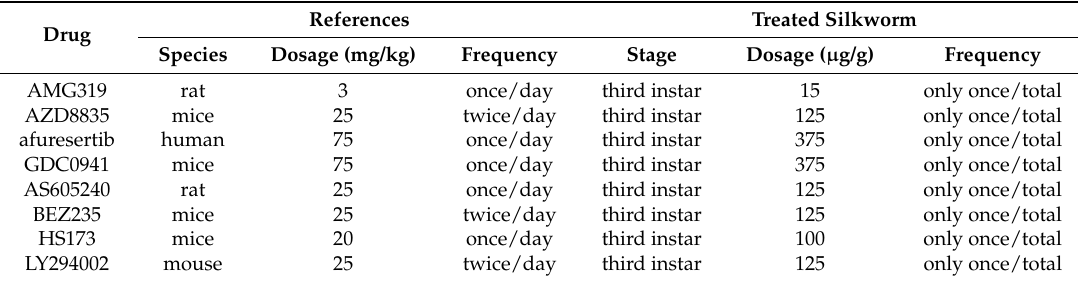
Table 2. Summary of candidate drugs.